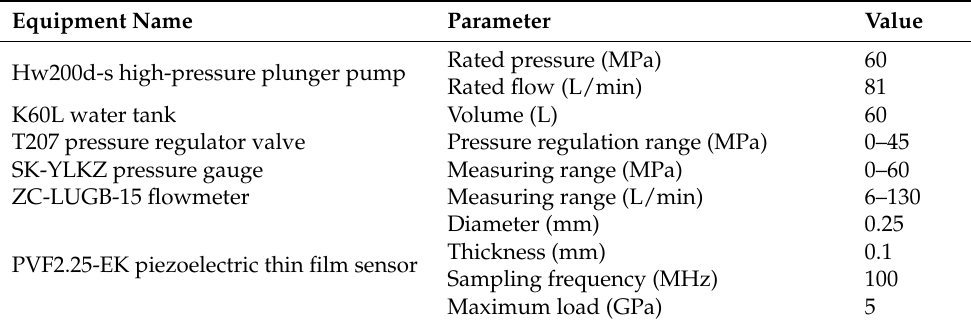
Figure 2. Experimental equipment: ( a ) high-pressure water jet system; ( b ) performance test system. Table 1. Main technical parameters of the water jet testing